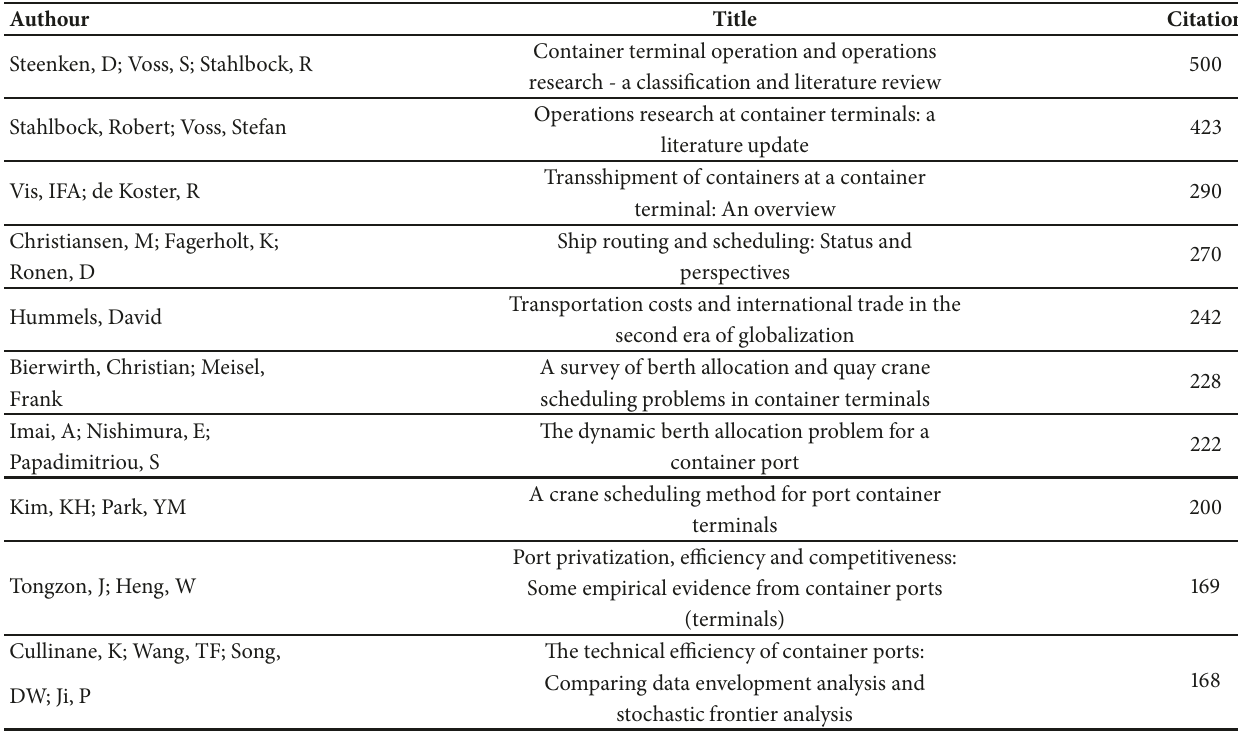
Table 5: The top 10 articles of port and maritime research